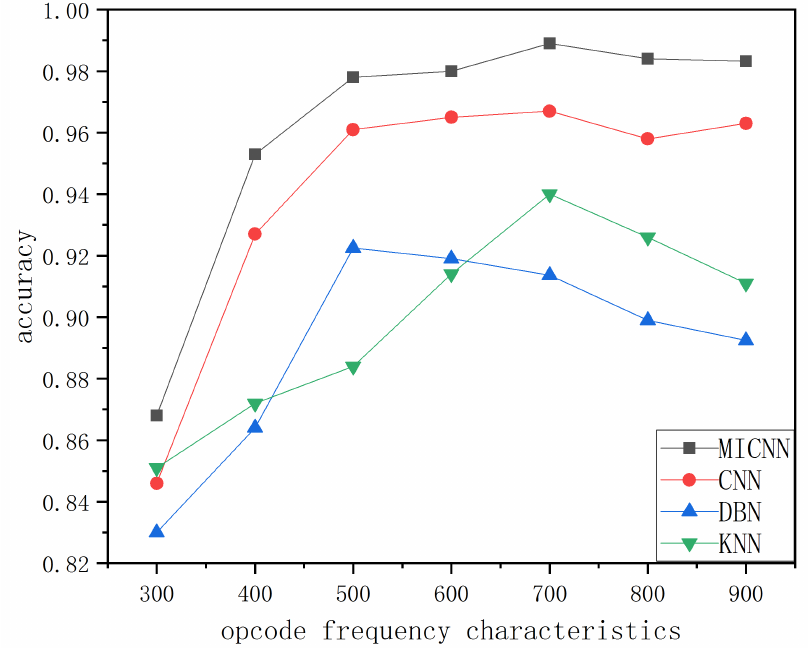
Figure 5. Simulation of opcode